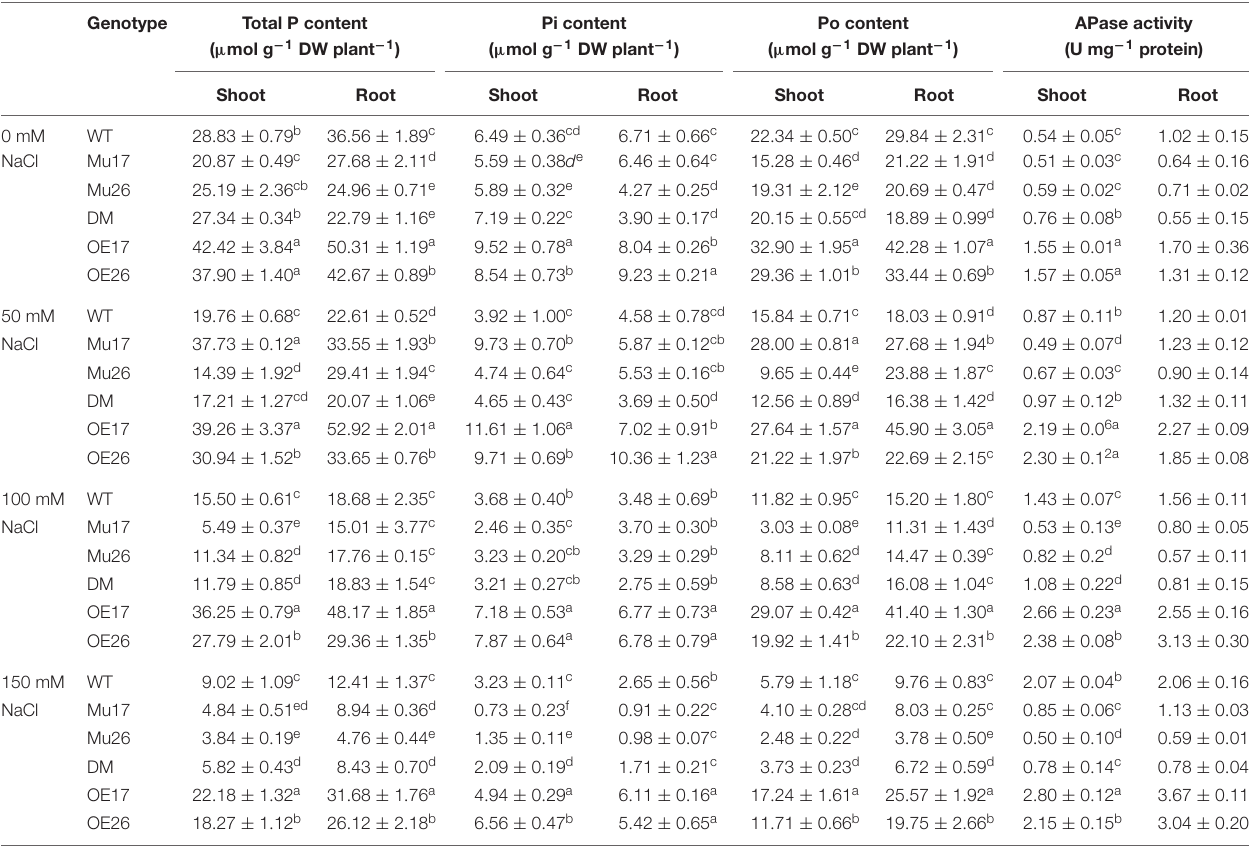
TABLE 4 | Means ( ± SE) of the total P, free Pi, and P organic contents in genotypes subjected to the NaCl concentrations. Genotype Total P content Pi content Po content APase